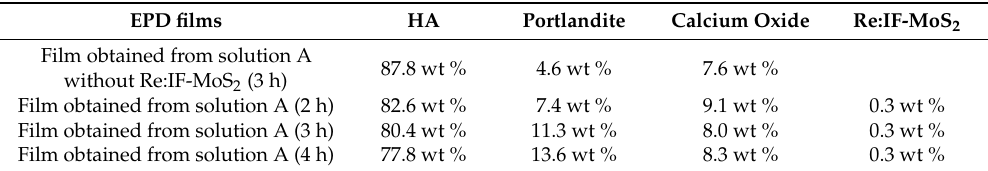
Figure 6. XRD patterns: Films obtained from solution A without the Re:IF-MoS 2 NP ( a ) and (with the IF NP) for different deposition periods: after 2 h ( b ), 3 h ( c ) and 4 h ( d ). Table 2. Composition of the film determined via XRD analysis for different deposition times (from solution A).